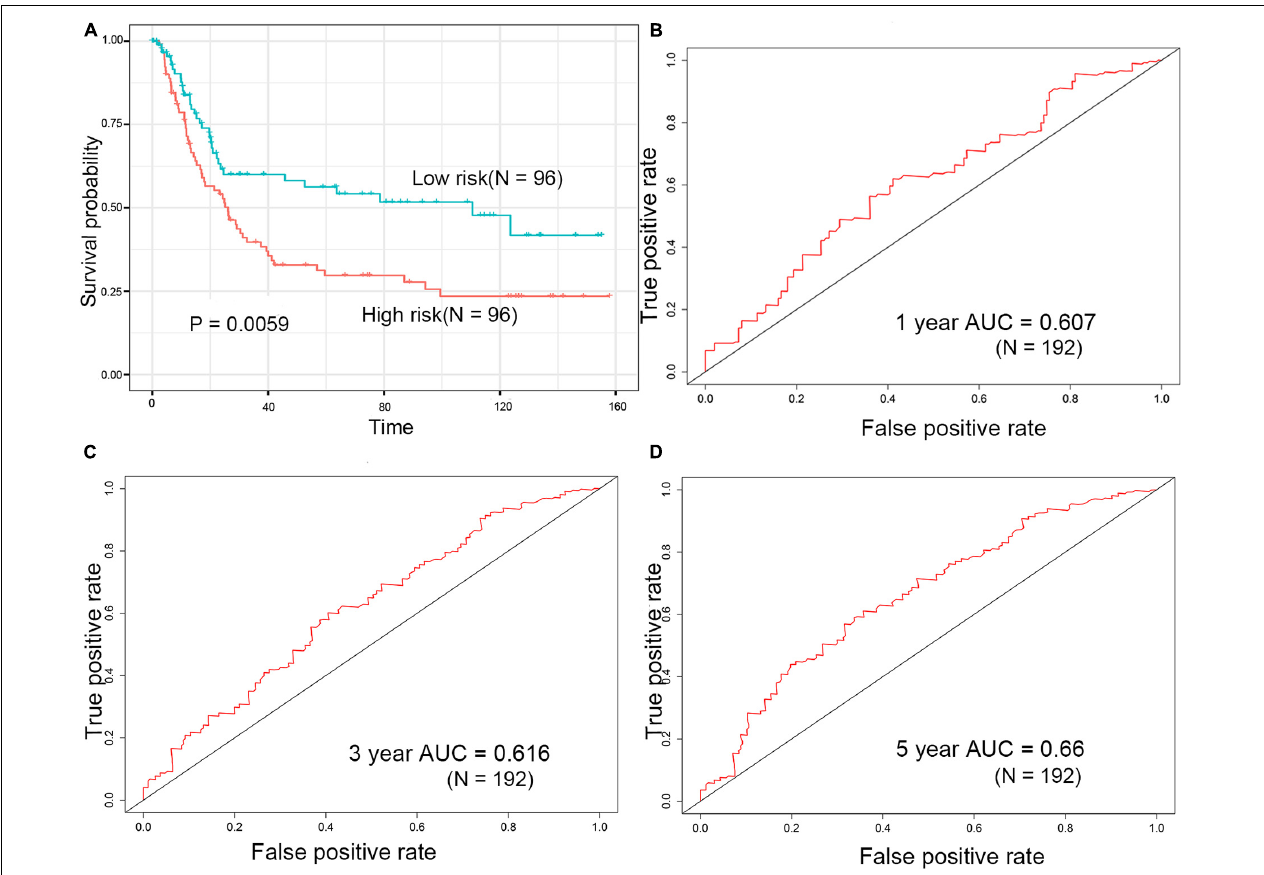
FIGURE 5 | Evaluation of prognostic signature for over survival in the GEO dataset. (A) Survival analysis of the high-risk group and the low-risk group in the GEO dataset. (B–D) ROC curve of the prognostic signature in the GEO dataset.